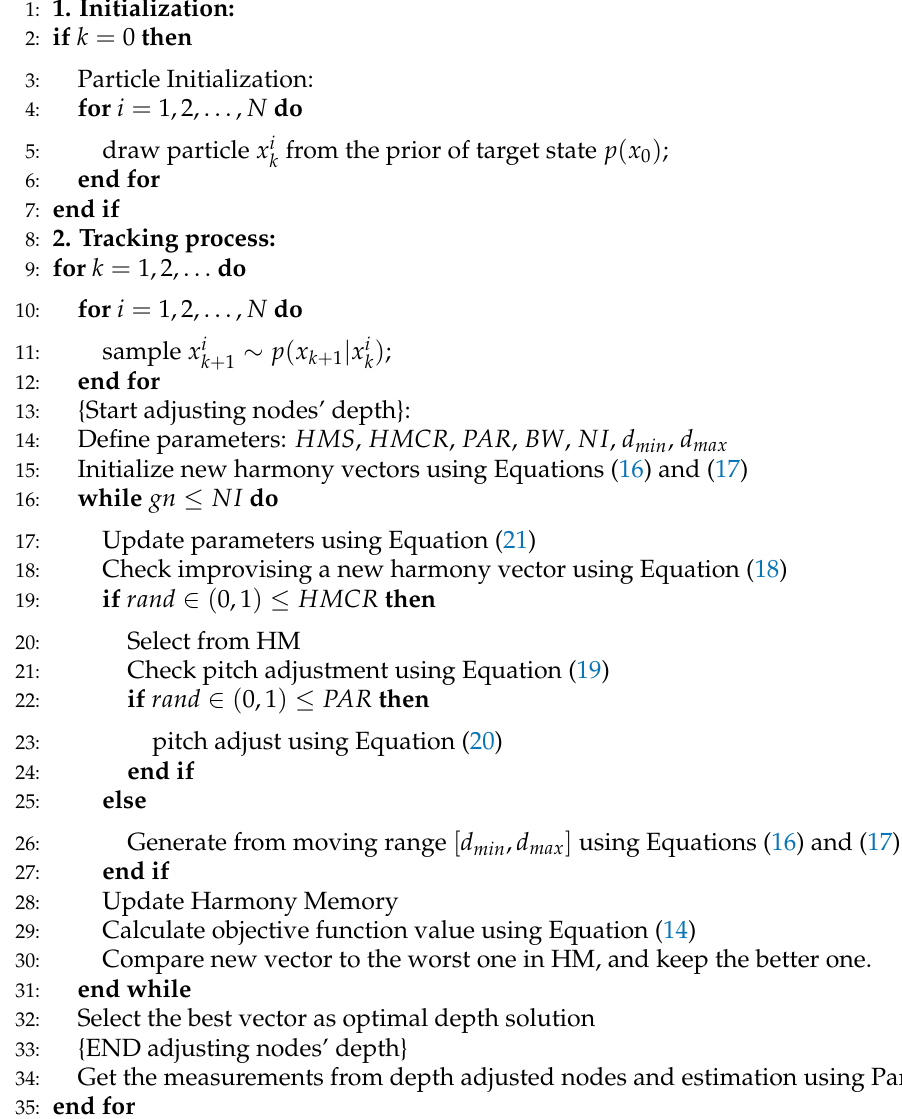
Algorithm 1 Node depth adjustment based target tracking scheme using improved harmony